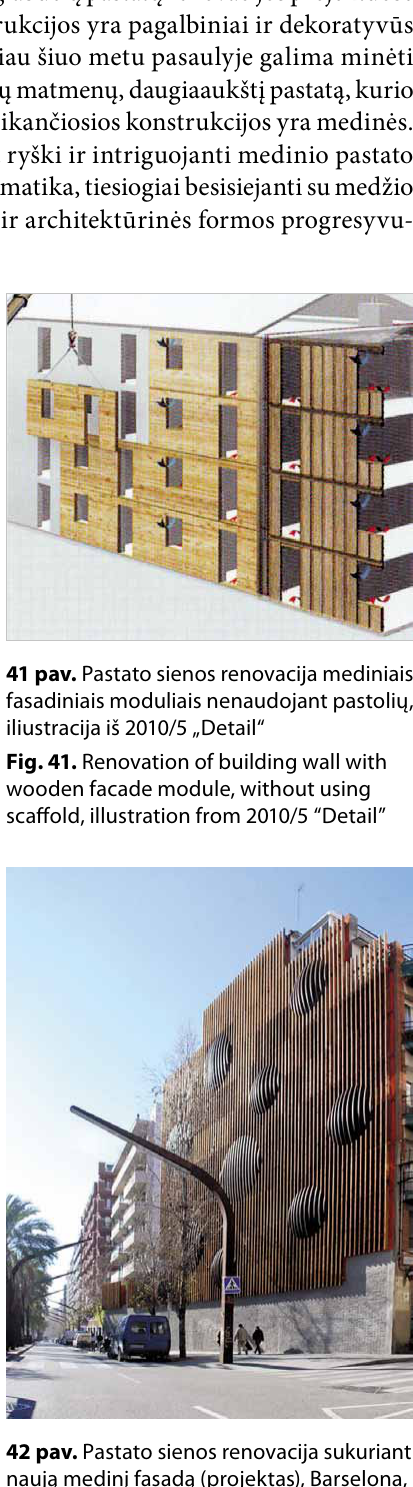
Fig. 42. Renovation of building wall with Fig. 44. Cultural center in Kirkenes (visualization),